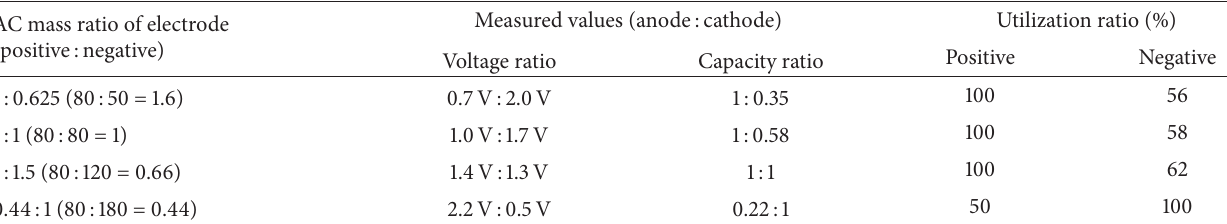
Table 1: Utilization efficiency of activated